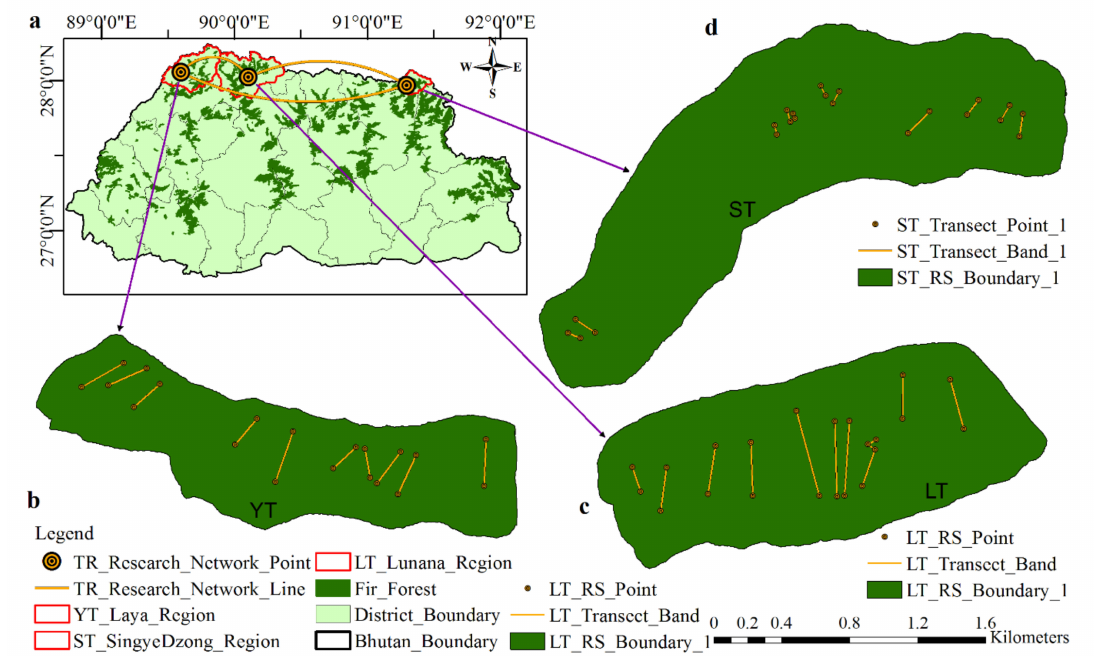
Figure 2. Treeline ecotone network regions and transect band sampling layout in Northern Bhutan. Three treeline ecotone sites (golden concentric circles) and three treeline ecotone regions (Lunana, Laya and Singye Dzong-pink shaded polygons) connected by thick curved golden lines. ( a ) Fir forest cover is shaded by dark green in Bhutan map. Map of three of sampling treeline ecotones (scale drawn) where laid transect bands (golden thick line) and stations (brown concentric circles) were shown in ( b ) Laya, ( c ) Lunana and ( d ) Singye